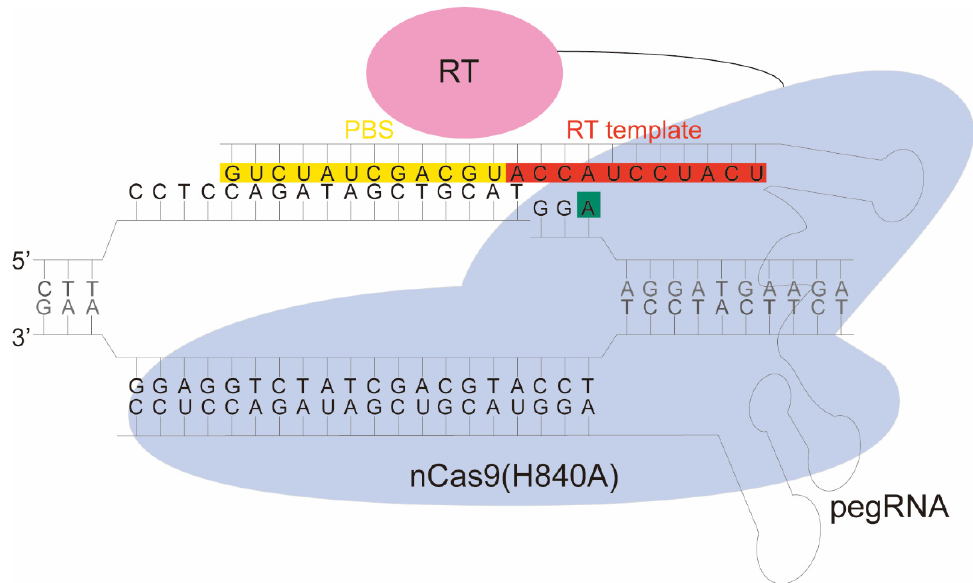
Figure 1. Illustration of PE system. Prime editor consists of nCas9(H840A) fused to reverse transcriptase (RT) via XTEN linker (a 16 amino acid flexible linker, black line). The fusion protein is guided by a pegRNA which consists of primer binding site (PBS), RT template and sgRNA. PBS (yellow), RT template (red). This figure shows how a mutation (+3 A to T) was introduced (green).